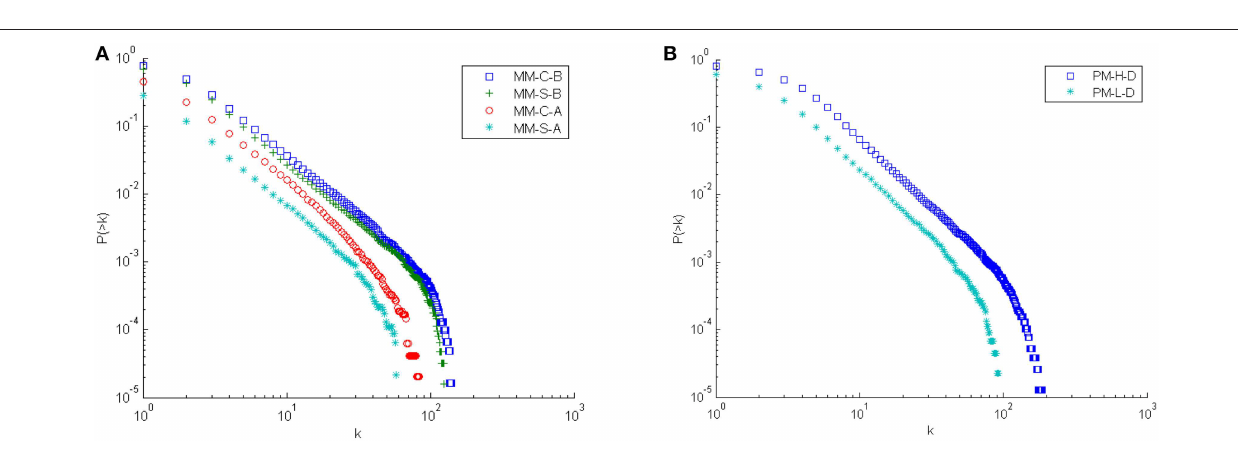
FIGURE 4 | Cumulative degree distribution for the three-dimensional DFN models. Results are based on 50 samples of each model. (A) Results for the mechanical model in all limits. (B) Results for the Poissonian model in both